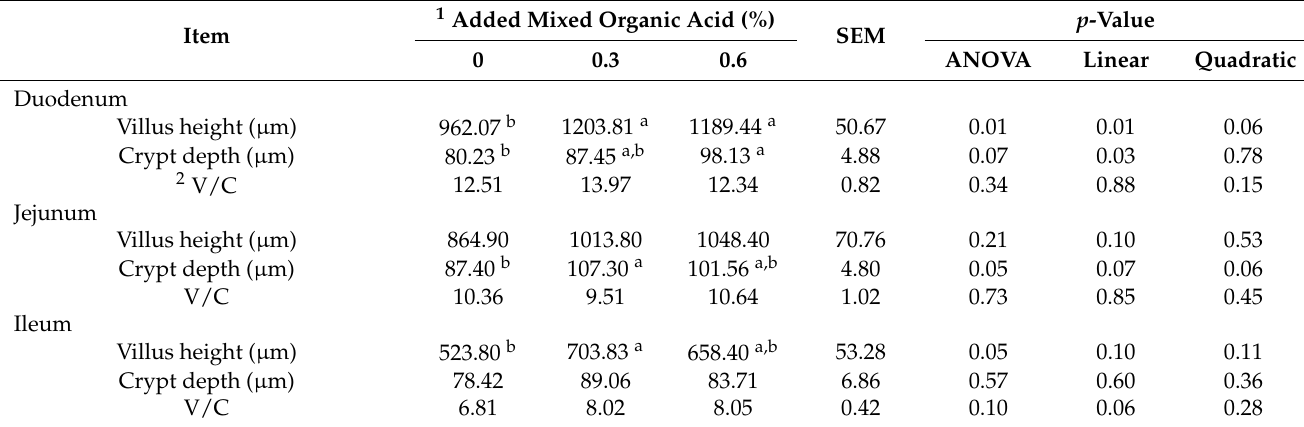
Table 7. Small intestine morphology of 42 d broiler chickens as affected by dietary MOA supplementation.